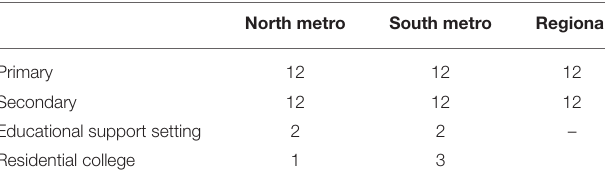
TABLE 1 | Stratification of DETECT Schools by geographical region and school